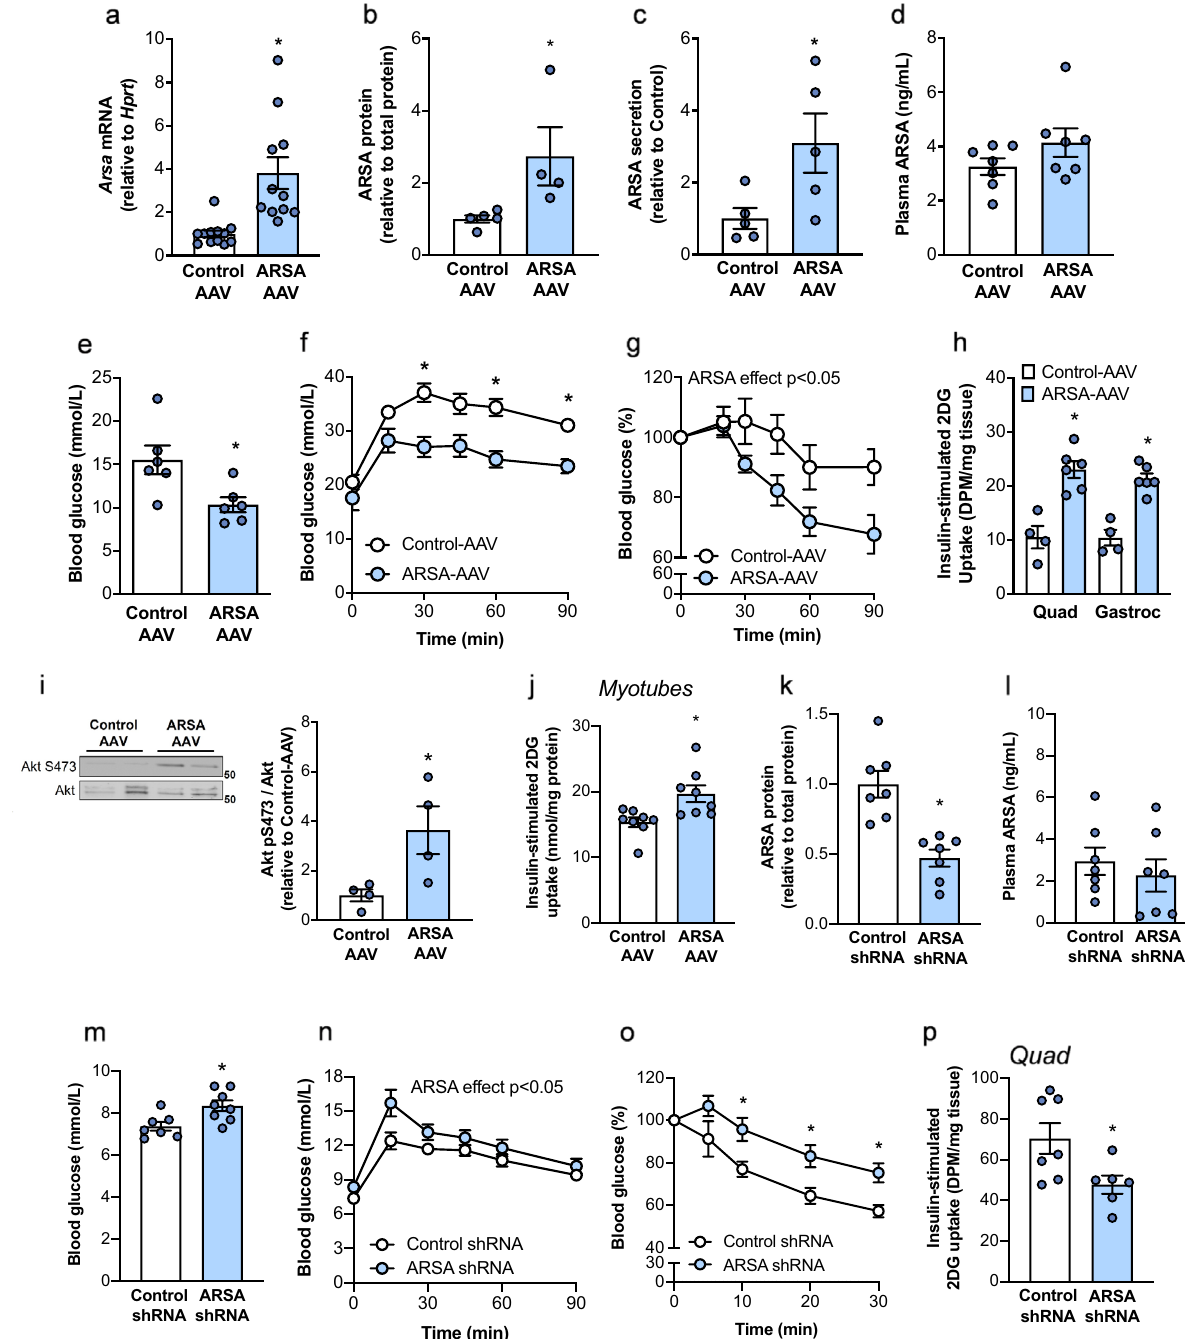
Fig. S4P), adiposity (Supplementary Fig. S4Q), oxygen con- sumption (Supplementary Fig. S4R), systemic fat or carbohydrate oxidation (Supplementary Fig. S4S), food intake (Supplementary Fig. S4T) or plasma NEFA, triglycerides and cholesterol levels (Supplementary Table S7). Overall, these experiments using both loss and gain-of-function approaches indicate that liver ARSA impacts systemic glycemic control by improving skeletal muscle insulin action. Liver ARSA does not directly modulate skeletal muscle lipid raft composition or insulin action . Having identi fi ed